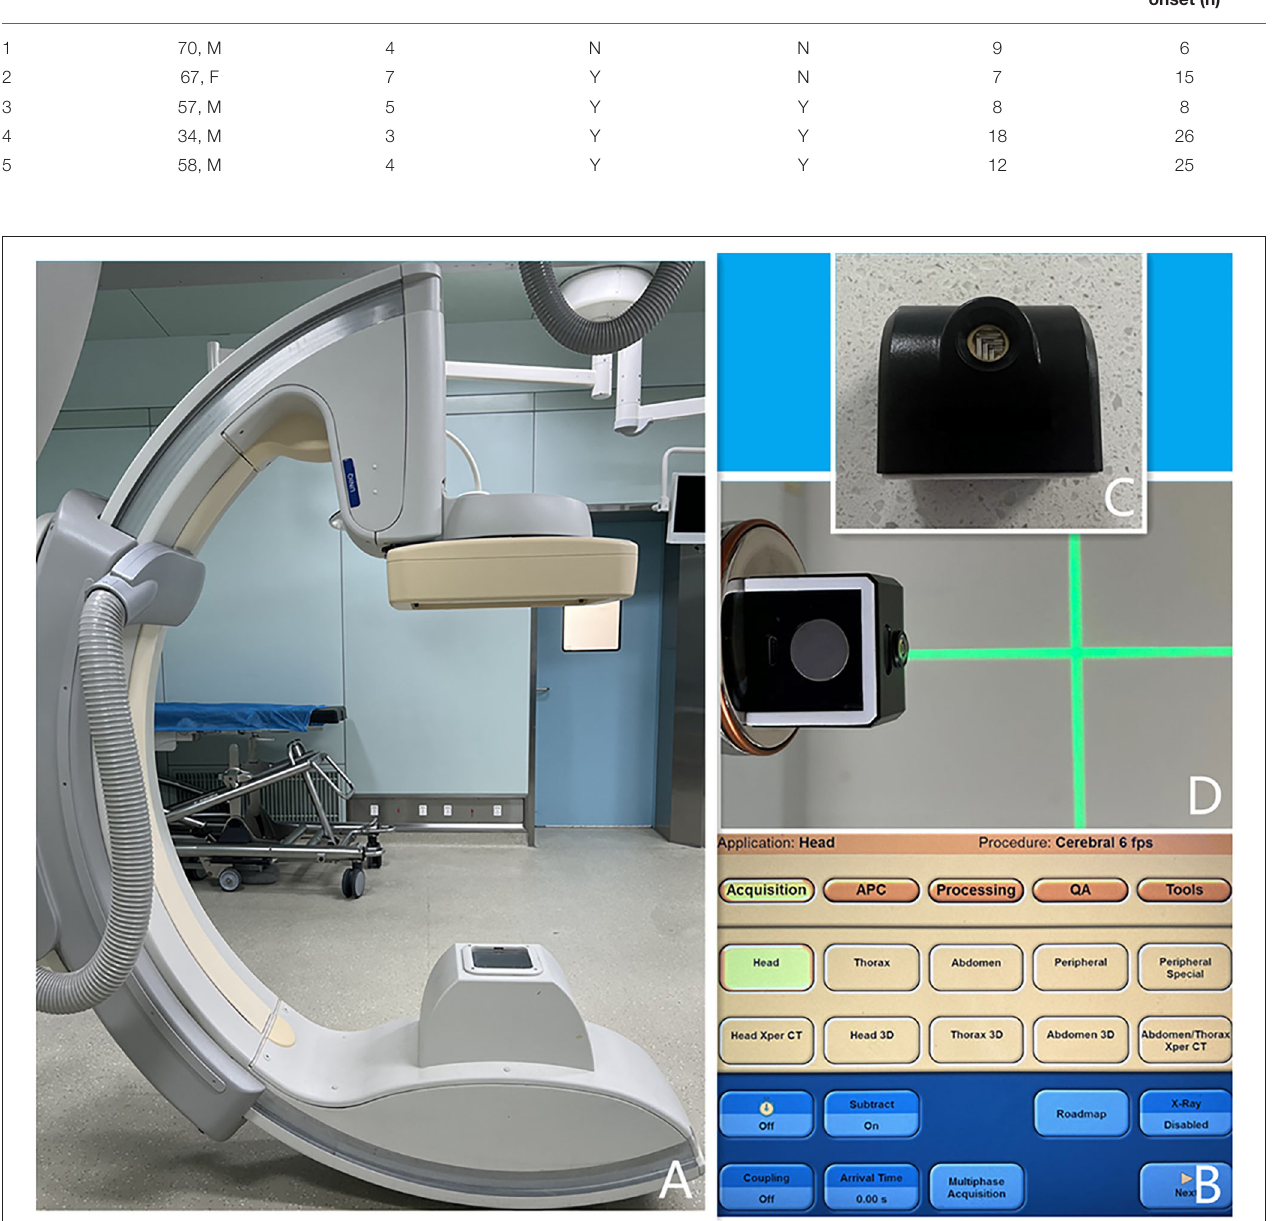
depth. When dark-red bloody fluid flew out, or the syringe slowly drew a dark-red blood clot ( Figure 3F ), the drainage tube entered the hematoma cavity and was fixed. A urokinase injection could be of assistance, according to postoperative CT and hematoma